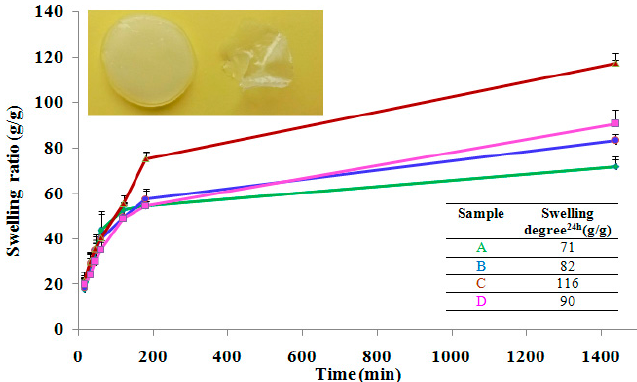
Figure 1. Time-dependent swelling profiles of the hydrogels and appearance of the hydrogels, dried and swollen state (~99% water); A-PMAA; B-PMAA-Cl 93A; C-PMAA-Cl 93A-C8; D-PMAA-Cl 93A- C18.